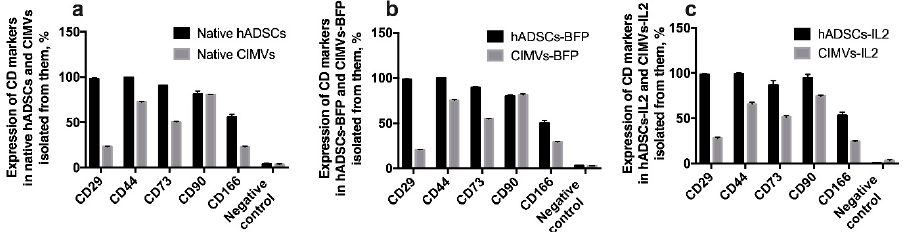
Figure 5. Immunophenotype of native hADSCs ( a ), hADSCs-BFP ( b ) hADSCs-IL2 ( c ) and CIMVs isolated from each cell line. Cells and CIMVs were analyzed using staining with antibodies typical for CD markers of MSCs detected by flow cytometry. The expression of typical surface MSC markers was significantly reduced in both native CIMVs ( a ), and genetically modified CIMVs-BFP ( b ) and CIMVs-IL2 ( c ). Each box represents the mean ± SD ( n = 6) of two biological replicates. Percentages on graphs represent cells positive for the markers from the parent population of all hADSCs or CIMVs.